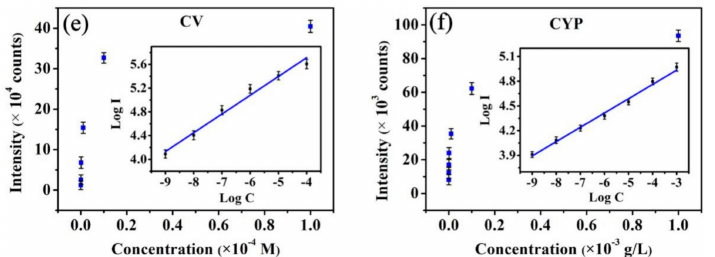
Figure 6. SERS spectra obtained from different concentrations of: ( a ) 4-ATP; ( b ) CV; and ( c ) CYP solutions absorbed on the Ag/FCW-10 substrates. The quantitative relation curves for the logarithm of the integrated SERS intensities and corresponding solution concentrations of: ( d ) 4-ATP; ( e ) CV; and ( f ) CYP.